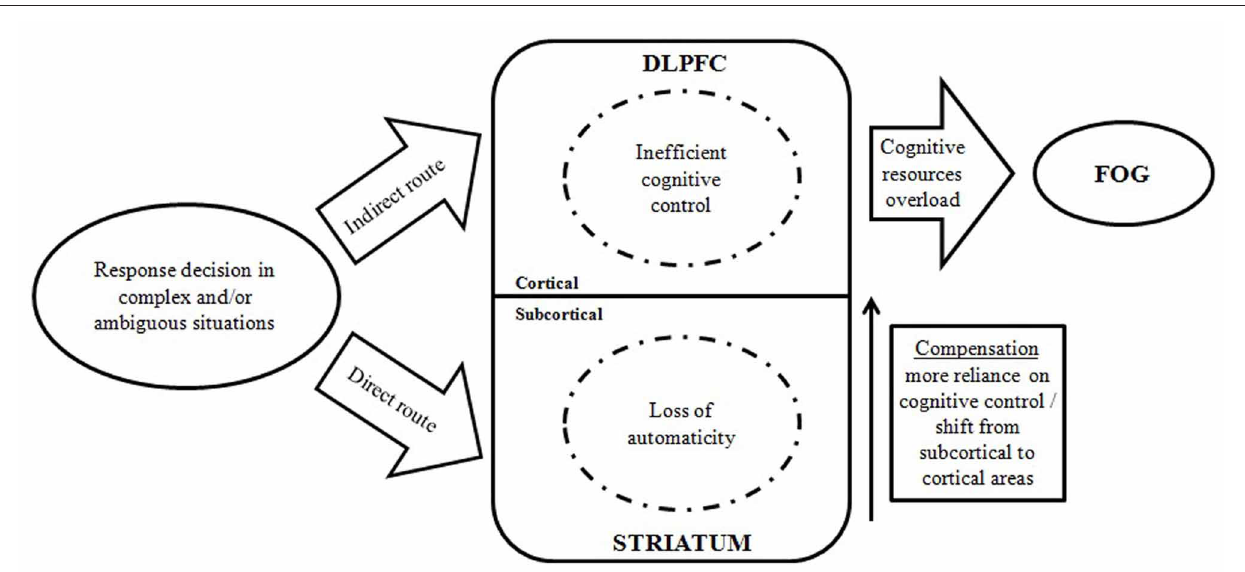
FIGURE 1 | Model demonstrating the interplay between automatic and controlled cognitive dysfunctions in the occurrence of FOG episodes. (DLPFC, dorsolateral prefrontal cortex; FOG, freezing of gait).